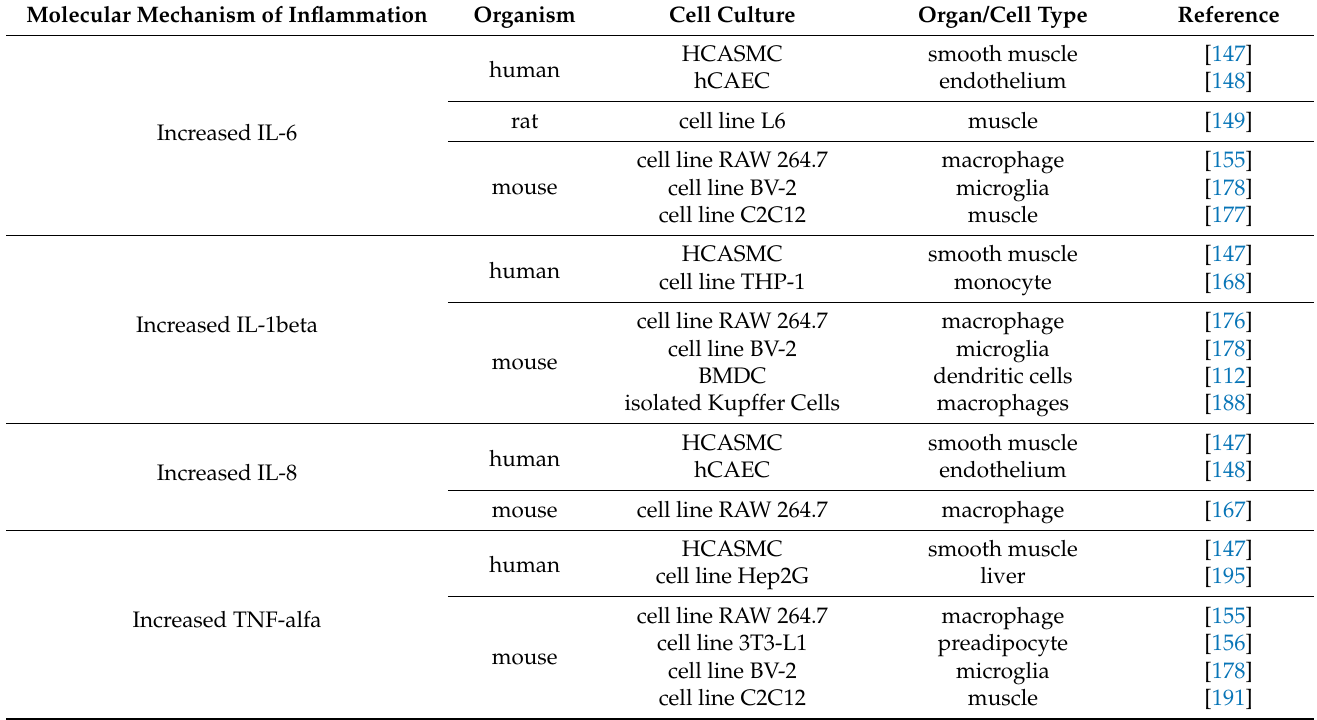
Table 3. Selected molecular mechanisms of lipotoxic inflammatory response and their sites of confirmed